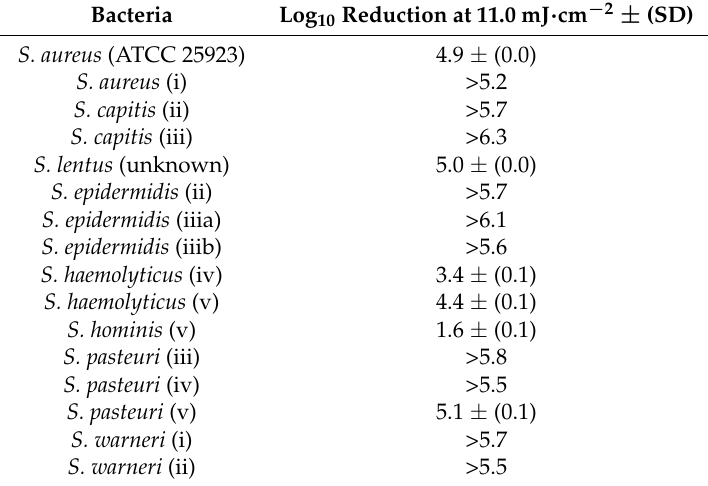
Table 2. Log 10 reduction of the American Type Culture Collection (ATCC) and wild Staphylococcus isolates.